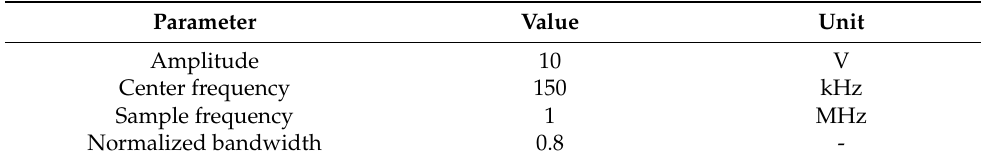
Table 4. Parameters of the pulse waveform.